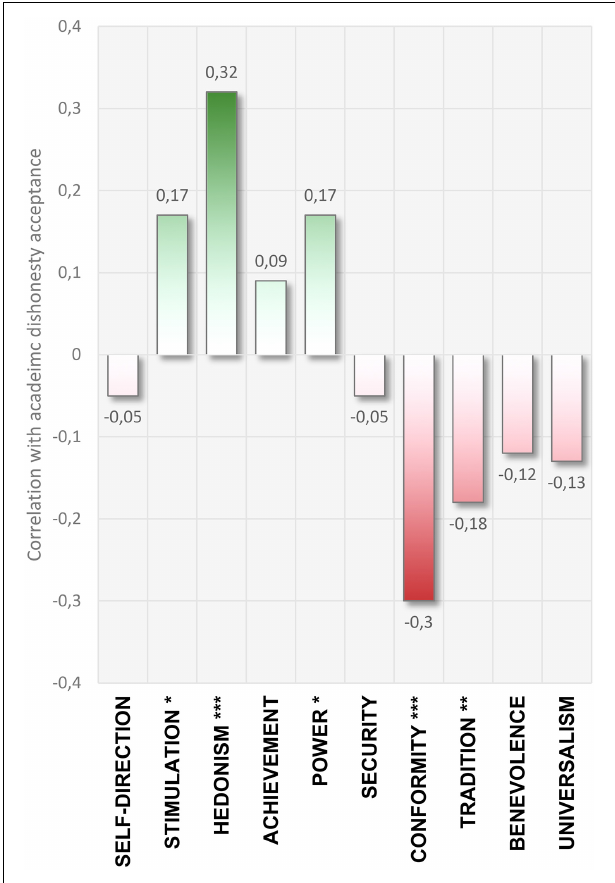
FIGURE 1 | Pearson correlation coefficients between: participants’ inclination toward academic dishonesty and their personal values (according to the theory by Schwartz, 1992). Self-direction, Stimulation, Hedonism, Achievement, and Power are considered Personal-Focus values, while Conformity, Tradition, Benevolence, and Universalism are called Social-Focus values. The extended matrix of the correlation values between all variables used in this study is included in the Supplementary Materials . ∗ p < 0.05; ∗∗ p < 0.01; ∗∗∗ p <